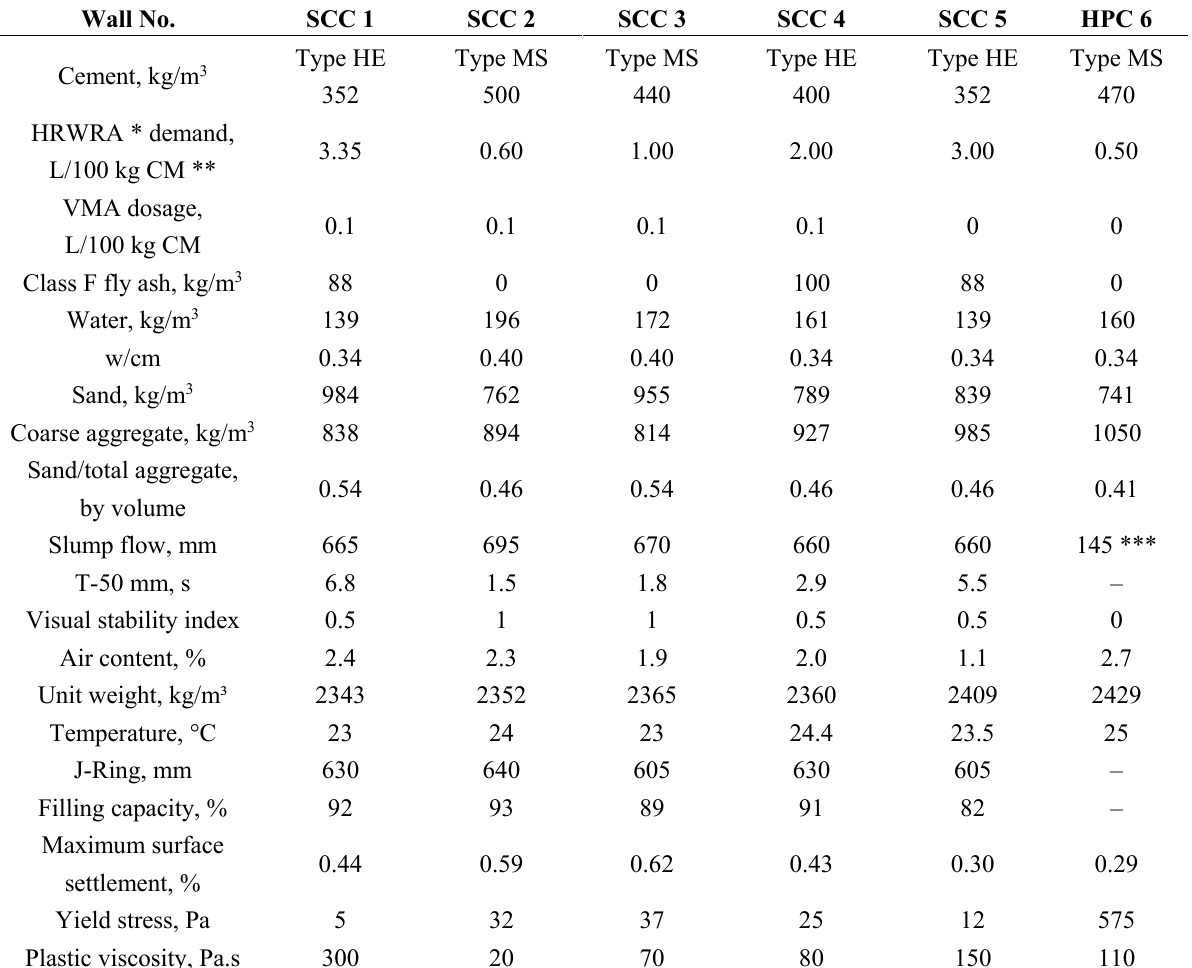
Table 2. Mixture proportioning and workability characteristics of tested